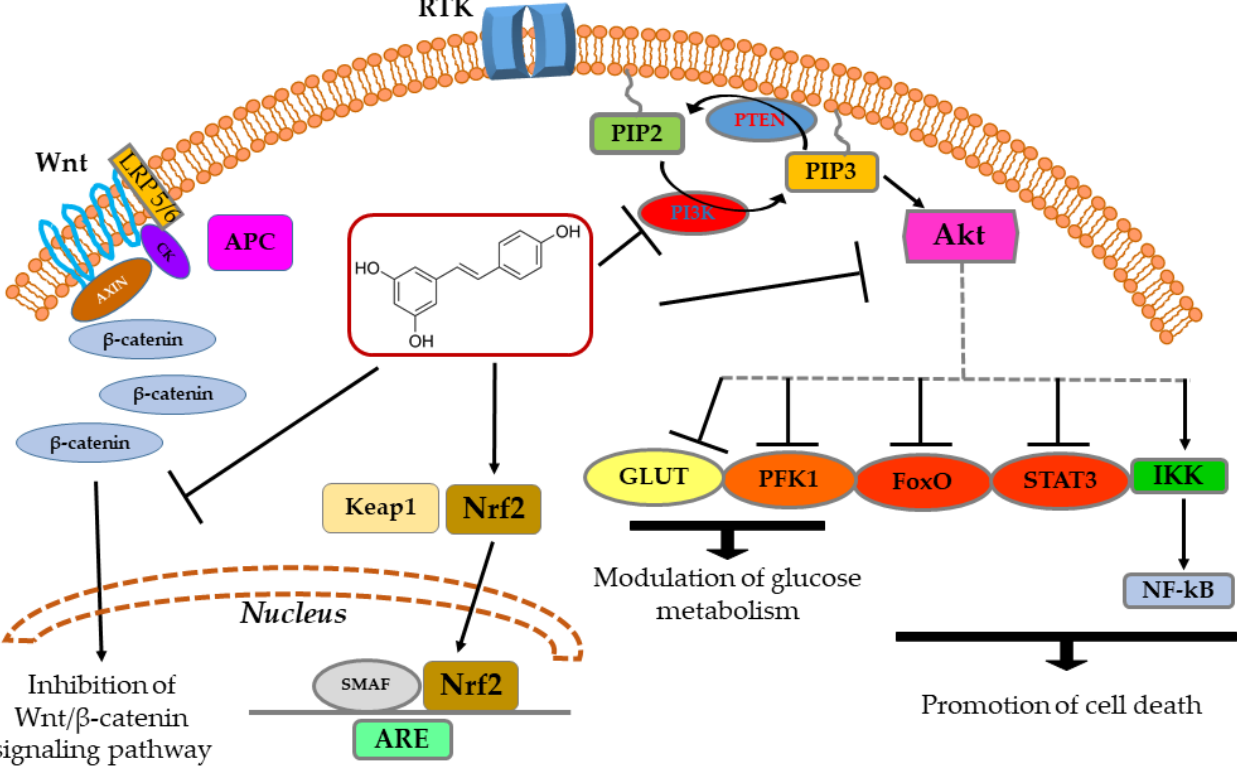
Figure 1. Chemical structure of trans -resveratrol (in the dark-red rectangle) and main biological pathways affected.